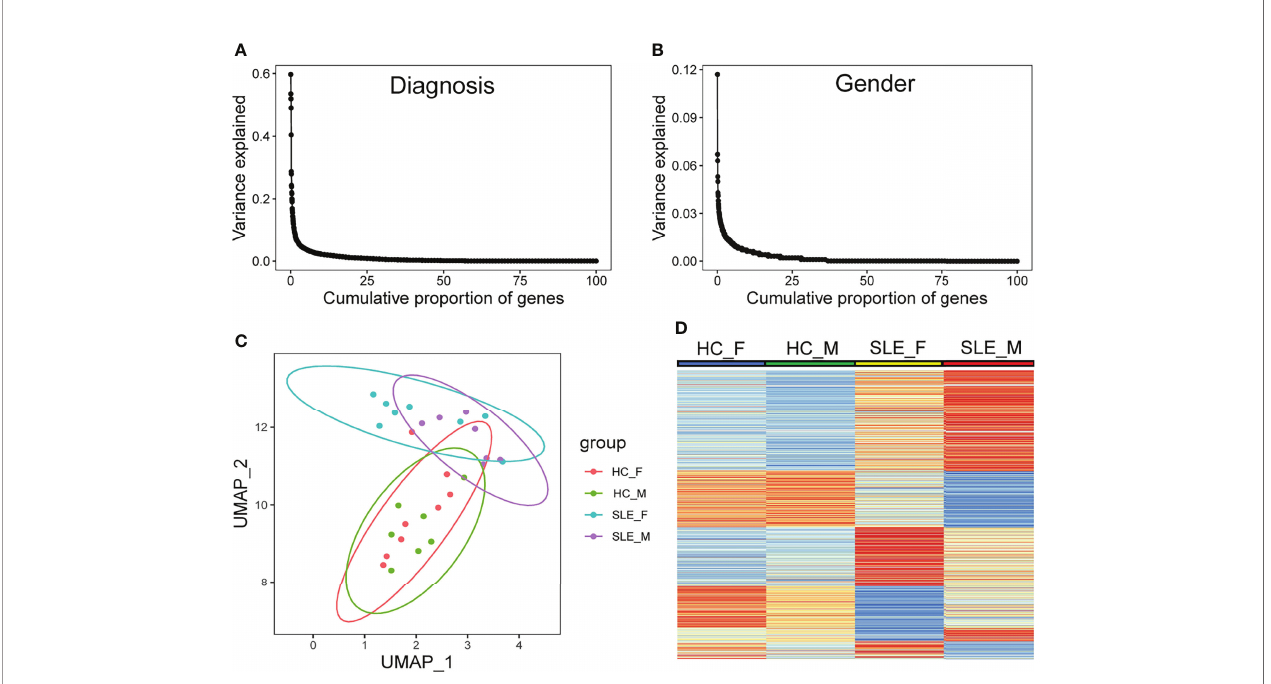
FIGURE 1 | Diversity in protein abundance among SLE and healthy control with different gender. (A, B) Proportion of gene-expression variance explained by diagnosis and gender. (C) UMAP plot of all identi fi ed proteins. (D) Heatmap plot showing differentially expressed proteins in any comparison group among male HC, male SLE, female HC, and female HC. HC_F, female healthy control; HC_M, male healthy control; SLE_F, female SLE; SLE_M, male SLE.